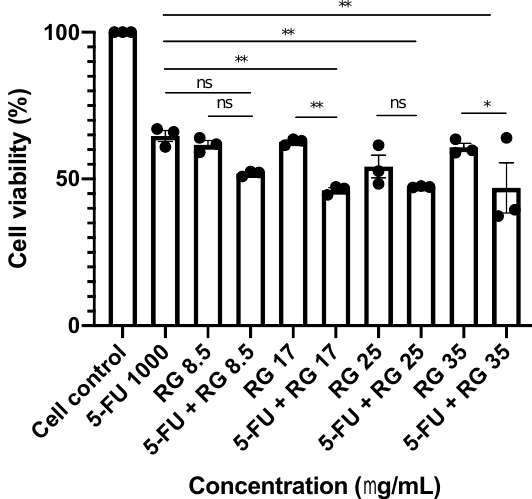
Figure 4. Effect combination of 5-FU and red ginger (RG) extract in WiDr cells at 24 hours